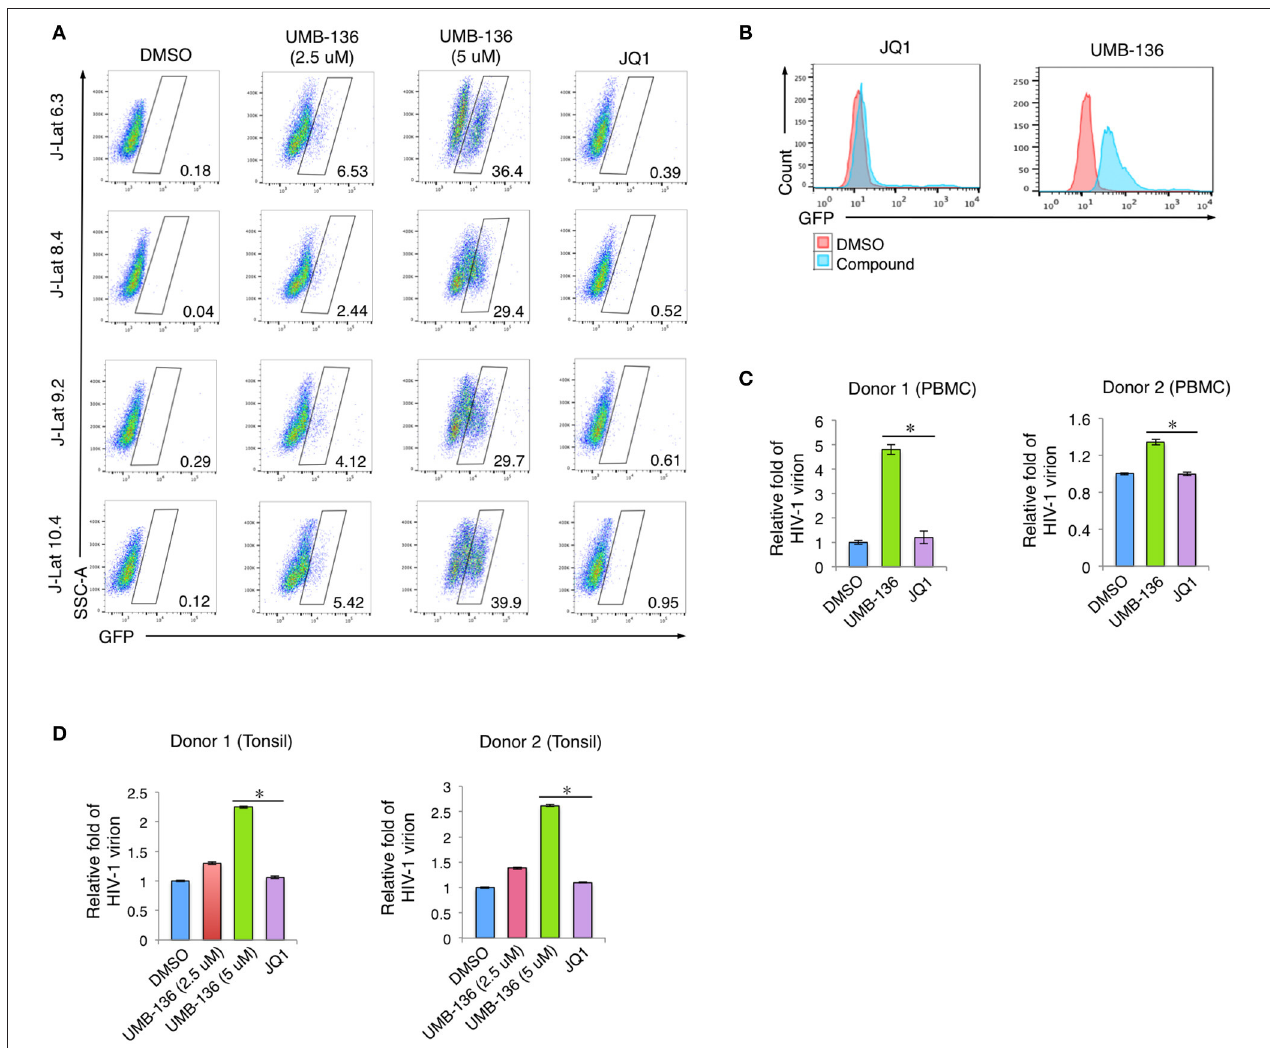
FIGURE 3 | UMB-136 reverses HIV-1 latency from multiple cell models of HIV-1 latency. (A) Multiple J-Lat cell clones (6.3, 8.4, 9.2, and 10.4, CD4 + T cell background) were treated with UMB-136 (2.5 or 5 µ M) or JQ1 (1 µ M). GFP-positive cells were acquired and analyzed by flow cytometry. Percentage of GFP-positive cells was determined. One representative of three independent experiments was shown. (B) THP89GFP cells (monocyte/macrophage background) were treated with UMB-136 (5 µ M) or JQ1 (1 µ M). GFP-positive cells were acquired and analyzed by flow cytometry. The HIV-reactivated cell population was indicated. (C) HIV-1 latency was established in the CD4 + T cells isolated from the peripheral blood mononuclear cells (PBMCs) of 2 donors, following a previously reported primary cell model (Vicente Planelles). Cells latently infected with wild-type HIV-1 NL4-3 viruses were treated with UMB-136 (2.5 µ M) or JQ1 (1 µ M). The viral mRNAs from newly produced HIV-1 viruses in supernatant were measured by qRT-PCR assay. (D) The same assay in (D) was conducted using the CD4 + T cells isolated from the tonsillar mononuclear cells (TMCs) of 2 donors. Results were presented as mean ± s.e.m. ( n = 3 ); * p < 0.05, t -test.